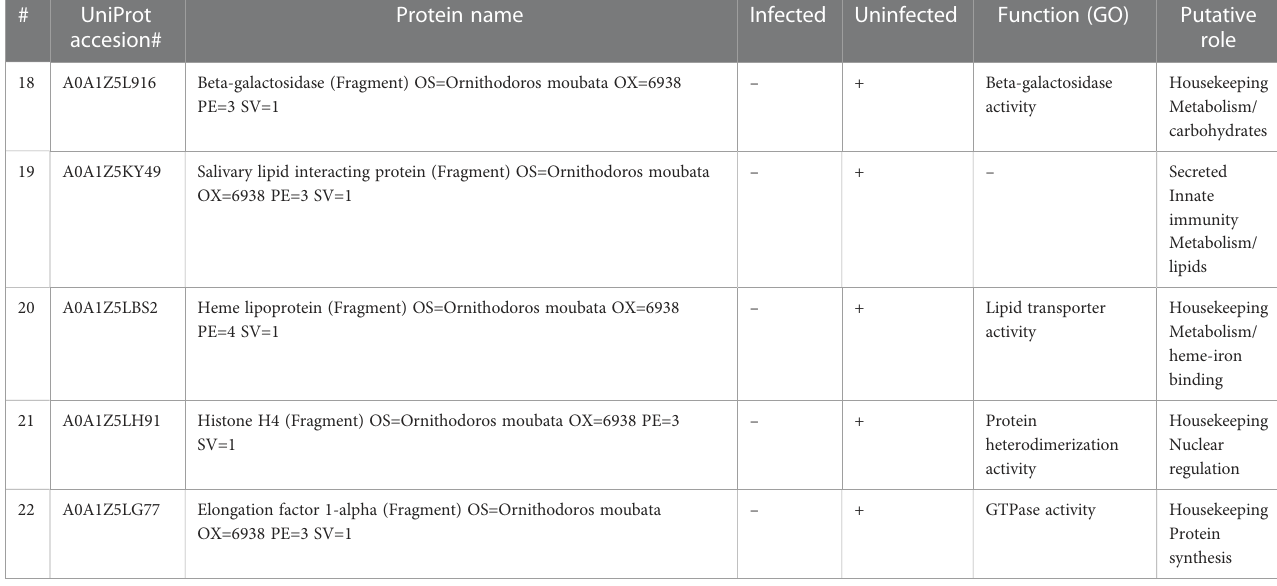
Protein function was assigned with the UniProt ’ s Retrieve/ID mapping tool. Underlined names indicate proteins that were identi fi ed in samples collected from both, B. duttonii infected and uninfected ticks. Names in bold font indicate proteins identi fi ed only in samples collected from infected